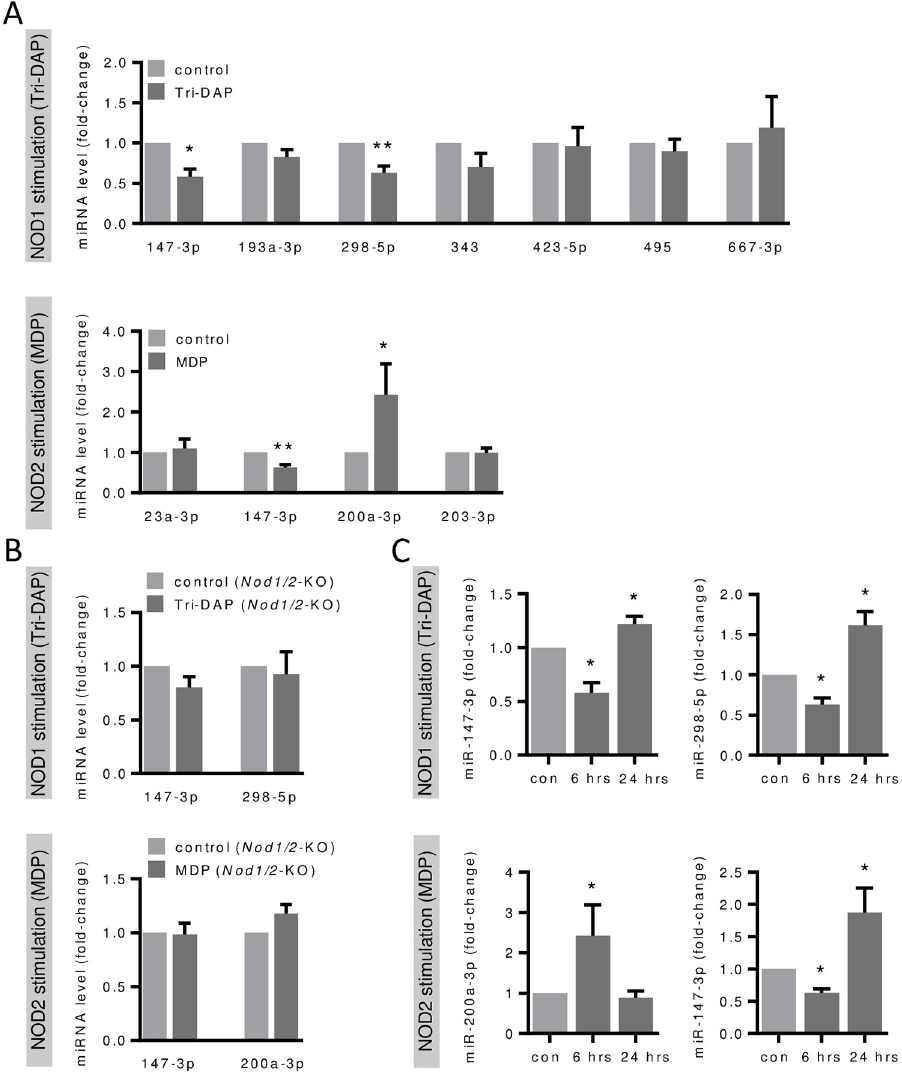
Fig 3. Validation of NOD1- and NOD2-dependently regulated miRNAs in murine pulmonary endothelial cells. Expression levels of the indicated miRNAs in cells from ( A ) wild type mice and from ( B ) Nod1/Nod2 -KO mice were analyzed 6 hours and from ( C ) wild type mice were analyzed 6 and 24 hours following Tri-DAP or MDP stimulation (each 10 μ g/mL) by real-time PCR. � P < 0.05, �� P < 0.01 vs. unstimulated control, n = 3–5.